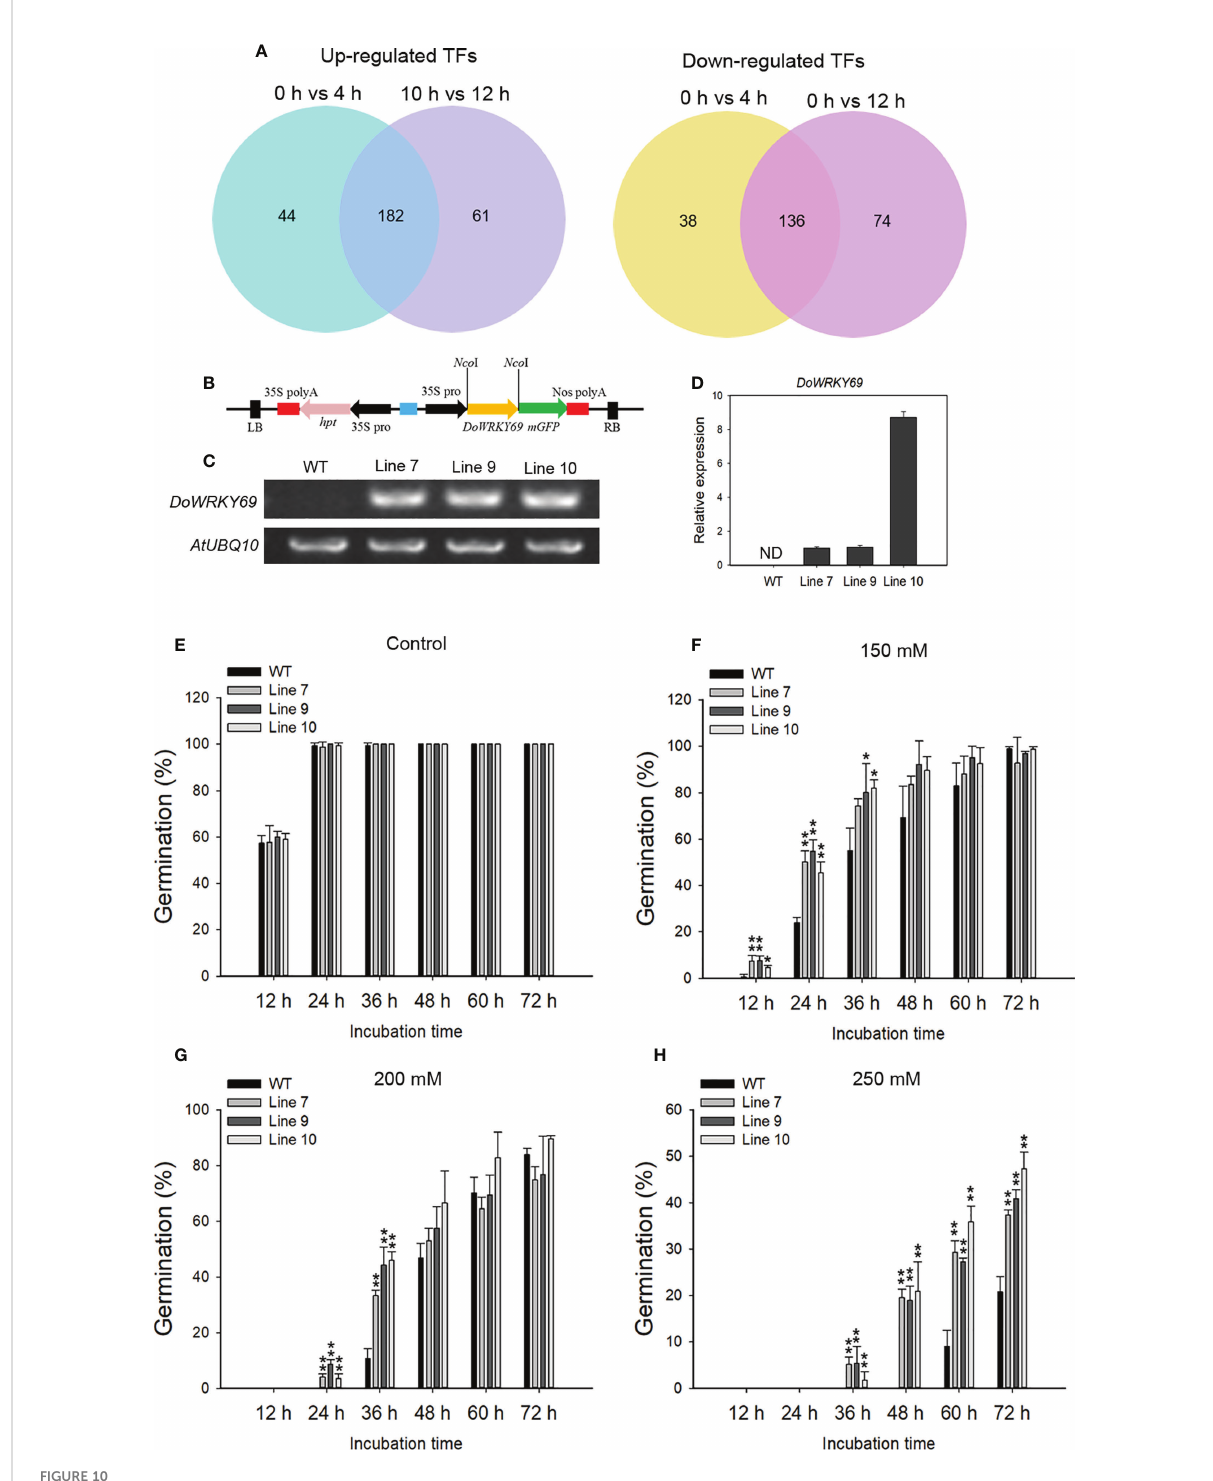
FIGURE 10 Identi fi cation of NaCl-induced TFs and characterization of one WRKY gene in the salt stress response. (A) Venn diagram of up-regulated TFs (left) and down-regulated TFs (right) from 0 h vs 4 h and 0 h vs 12 h comparisons. (B) The overexpression vector containing the DoWRKY69 gene is shown. Analysis of the expression of the DoWRKY69 gene in wild-type (WT) and 35S :: DoWRKY69 lines by using RT-PCR (C) and qRT- PCR (D) . (E) Germination of WT and 35S :: DoWRKY69 lines in the control (without NaCl), 150 mM NaCl (F) , 200 mM NaCl (G) and 250 mM NaCl (H) . Bars indicate means ± standard deviation of thee replicates. *, ** indicate signi fi cant differences at P < 0.05 and P < 0.01, respectively, according to the Dunnett test. About 60 seeds of each genotype were